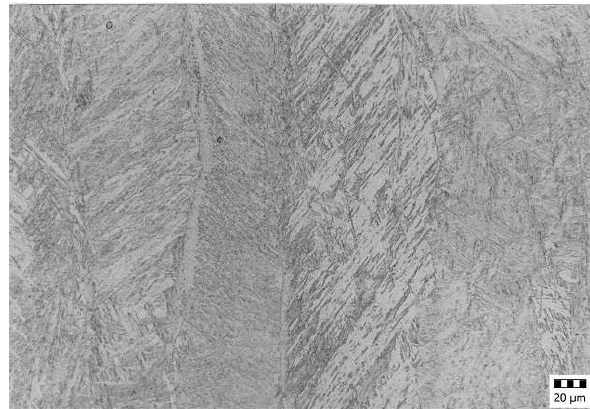
Figure 7: Microstructure of weld metal in the middle of weld nugget of sample B.